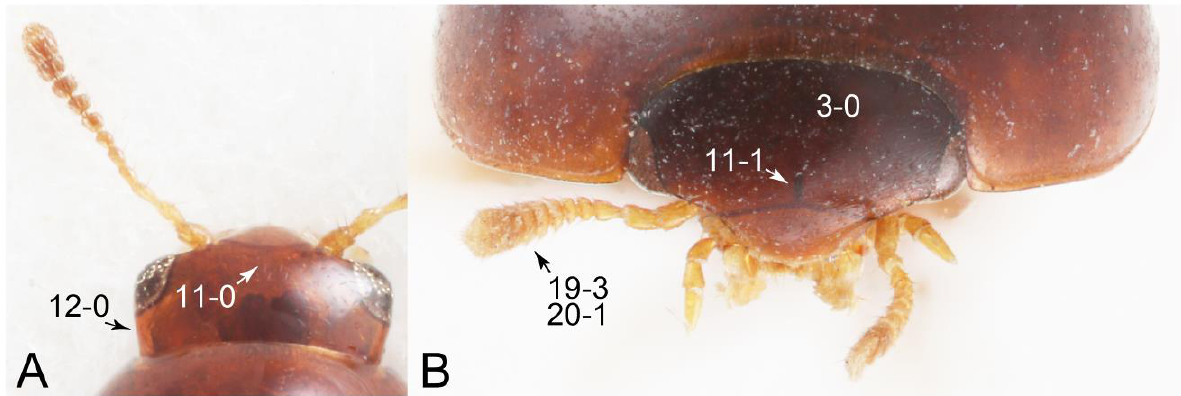
Figure 23. Photographs of body parts of Vatesini, head and pronotum, enlarged. ( A ) Mimocyptus sp., dorsal view. ( B ) Termitoplus grandis , frontal view. Characters and character states (format X-X) are indicated on each